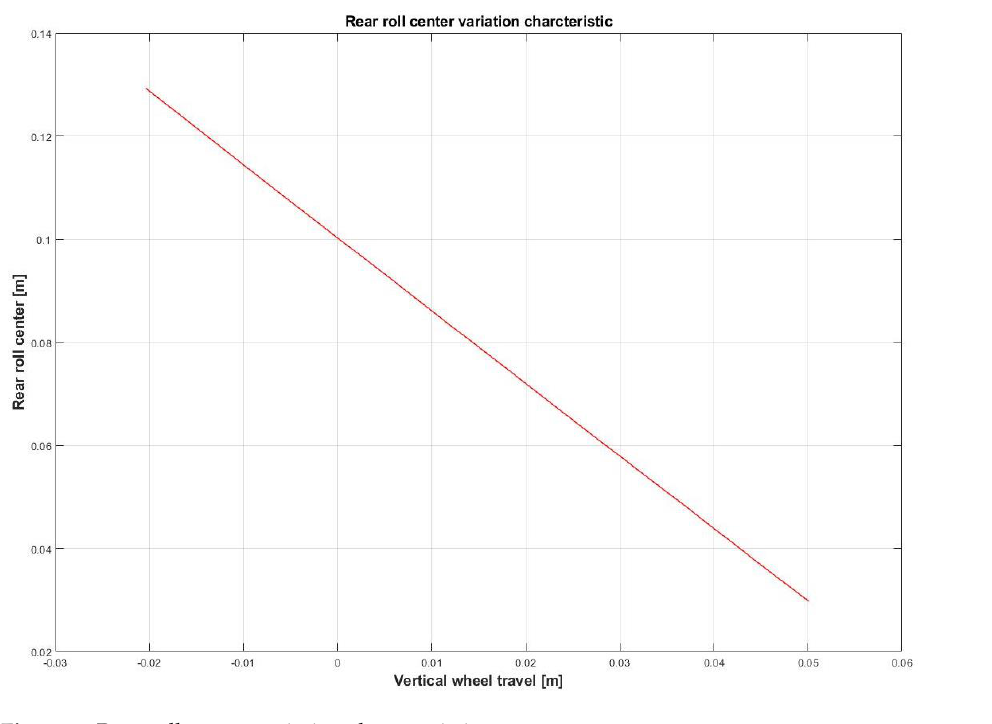
Figure 2. Rear roll center variation characteristic.